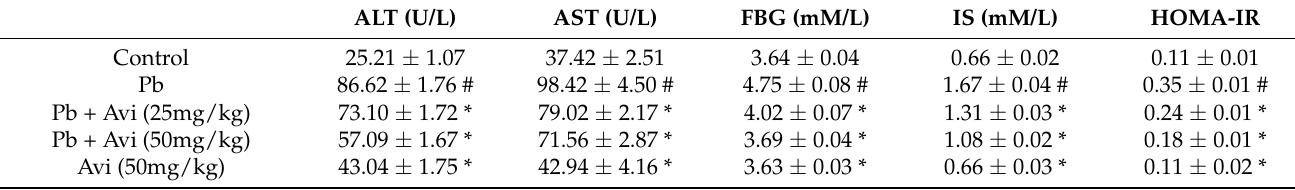
Table 1. Effect of avicularin on the serum biochemical parameters of mice. ALT (U/L) AST (U/L) FBG (mM/L) IS (mM/L) HOMA-IR Control 25.21 ±